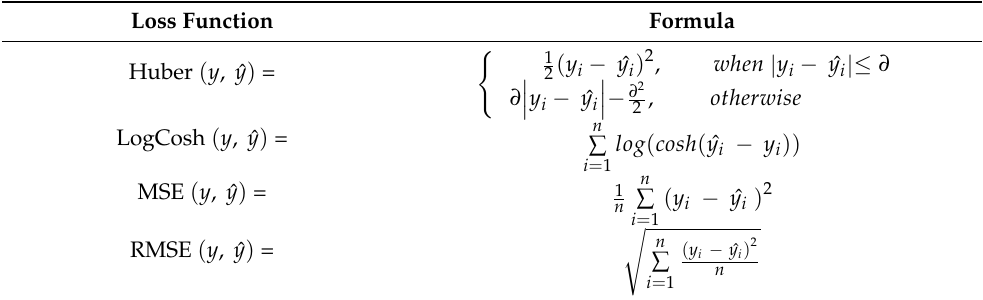
Table 2. Regression loss function formulas.